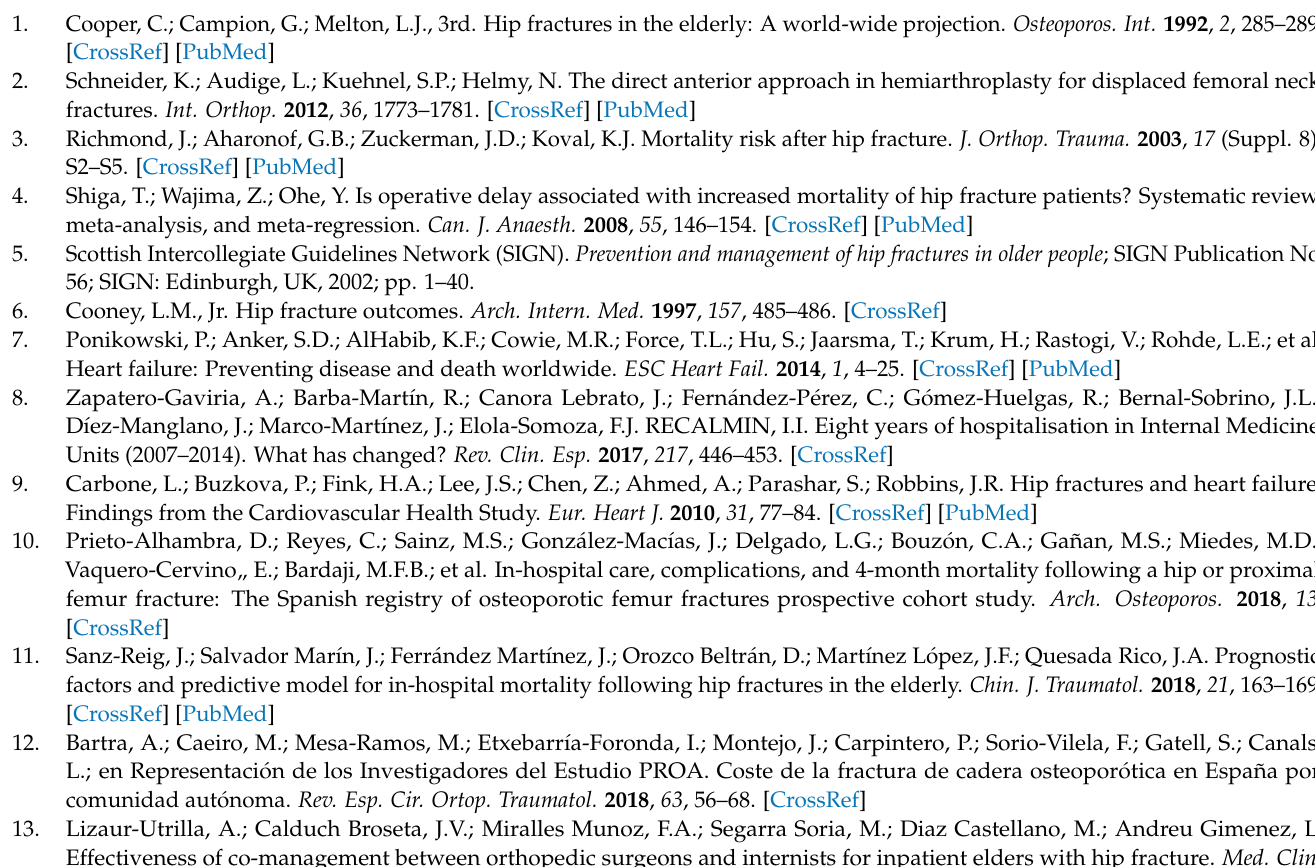
APR-DRG Risk Mortality Level, Table S2: Multilevel risk adjustment model of in-hospital mortality according to CMS-adapted model, Table S3: Poisson regression model for adjusting the length of